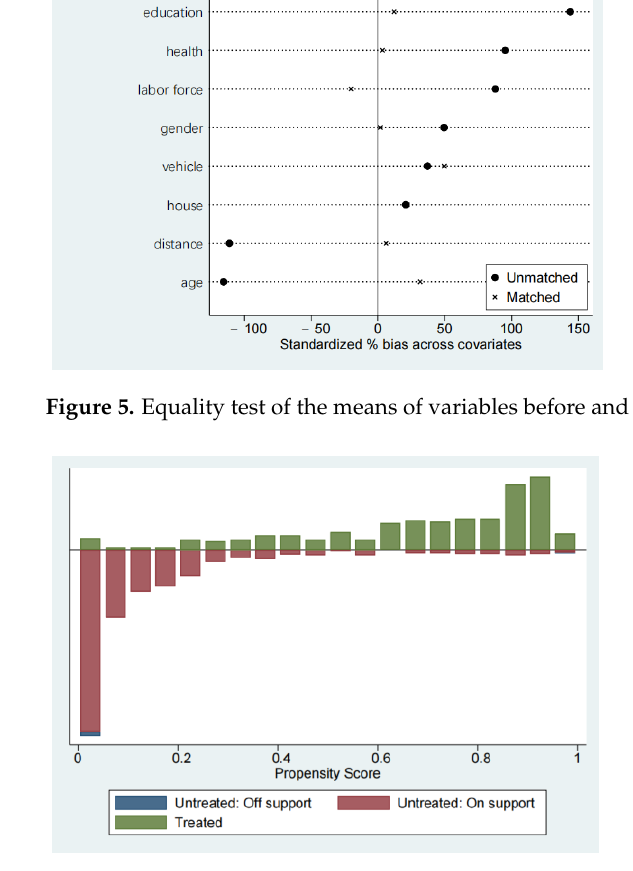
Figure 6. Propensity test score distribution and common support. Treated: On support indicates adopters of new kiwi varieties that had a suitable comparison group (non-adopters). Treated: Off- support indicates adopters of new kiwi varieties that did not have a suitable comparison group (non-adopters). Source: field survey, 2020.